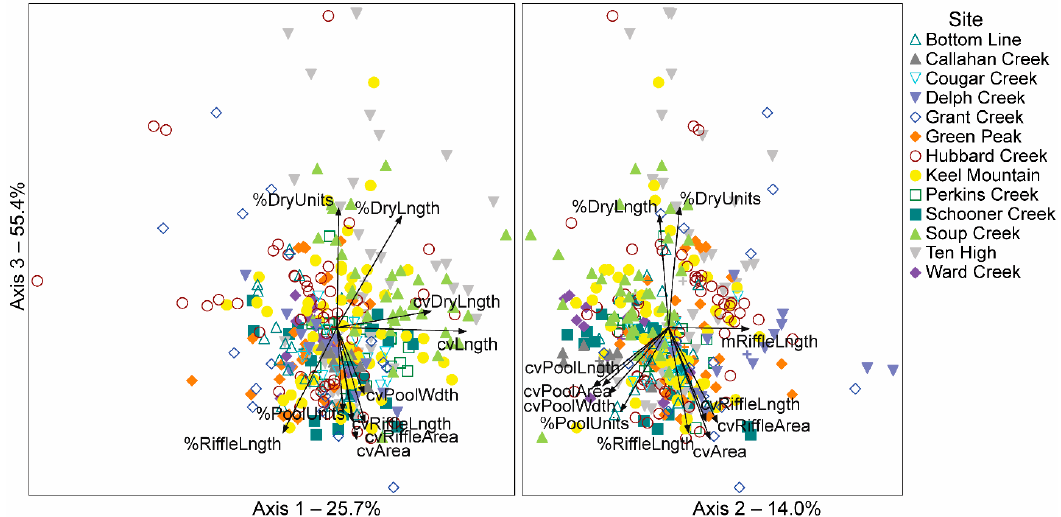
Figure 5. Three axis non-metric multidimensional scaling ordination of 65 reaches sampled repeatedly from 1995–2011 (no sampling in 2007; n = 362 total reach x year sample periods) described by 27 characteristics. Biplot vectors show relationships with reach characteristics in the main matrix (r 2 ≥ 0.30). Color codes highlight differences among and within sites. Percentages show the variance explained by each axis.